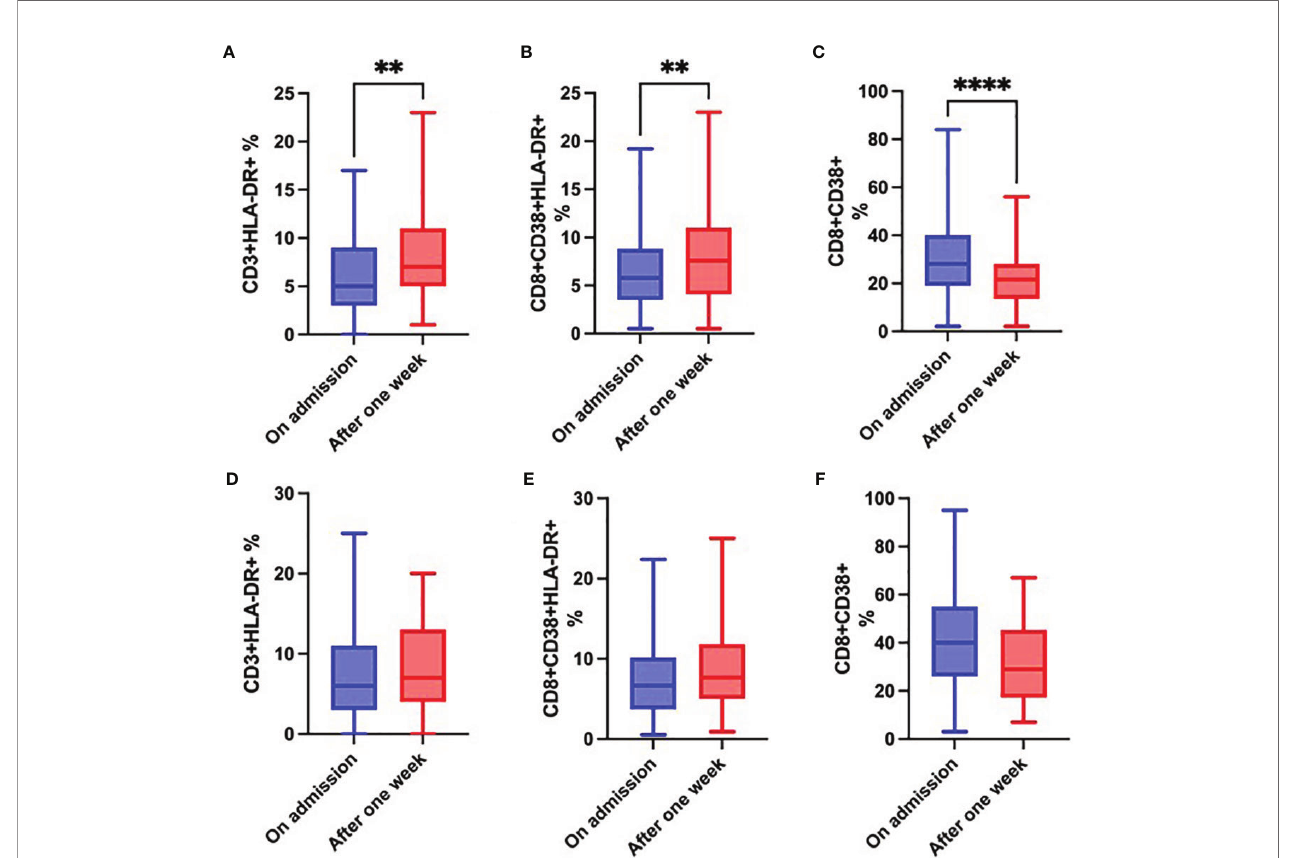
FIGURE 8 | Changes over time in the proportion of CD3 + HLA-DR + cells (A) , CD8 + CD38 + HLA-DR + cells (B) and CD8 + CD38 + cells (C) in survivors; and changes over time in the proportion of CD3 + HLA-DR + cells (D) , CD8 + CD38 + HLA-DR + cells (E) and CD8 + CD38 + cells (F) in non-survivors during the fi rst week of hospitalization, Wilcoxon rank-sum test. **p < 0.01; ****p <